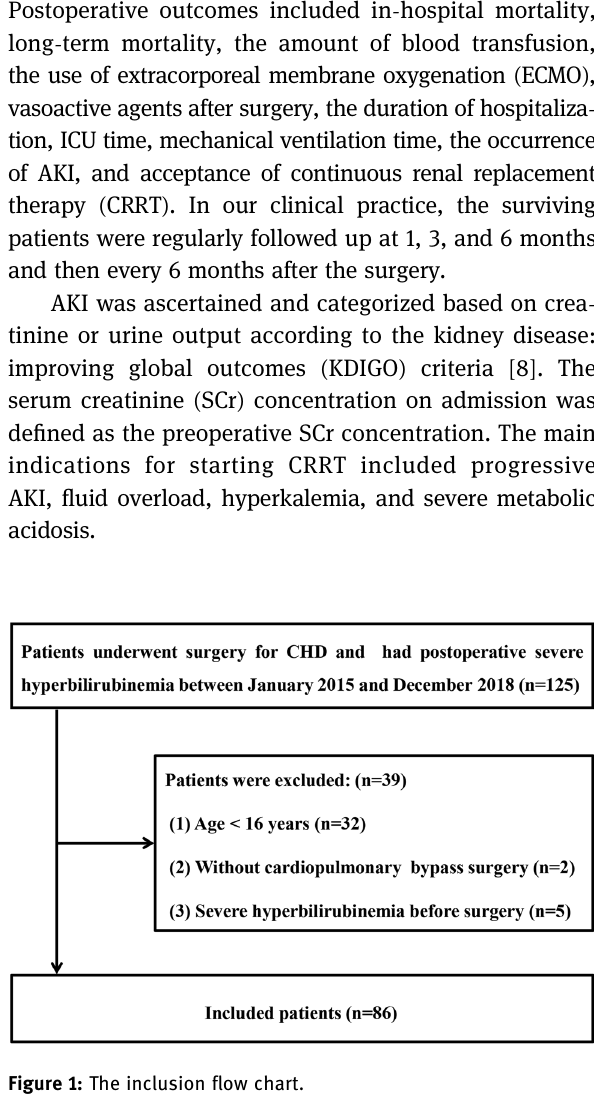
Figure 1: The inclusion fl ow